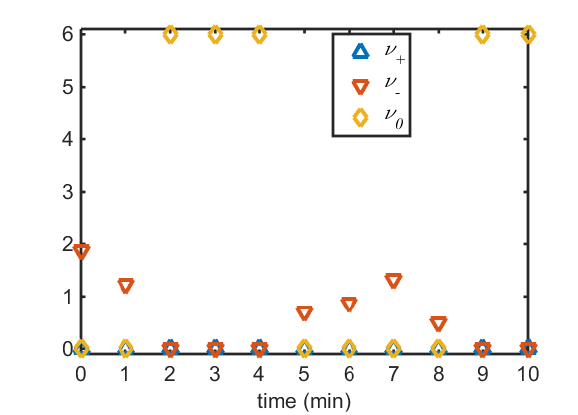
Figure 8. Complementarity variables used in the tank overflow